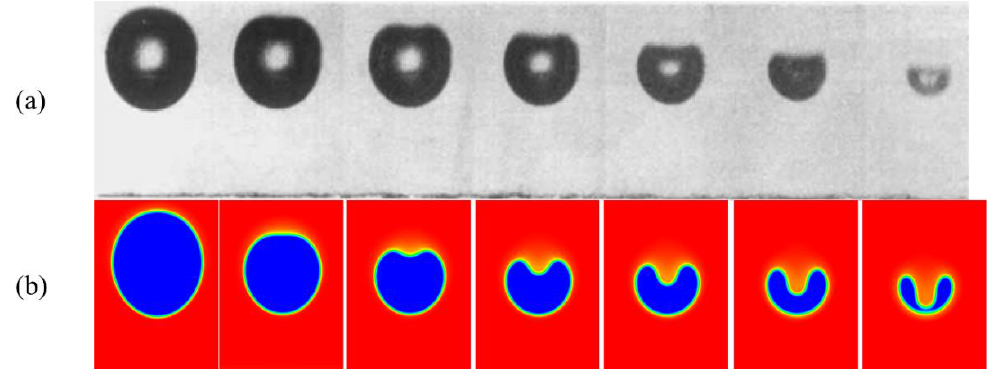
Figure 5. Comparison of experimental data and numerical results by DDF-LBM model. ( a ) Experimental data [60], reproduced or adapted from adequate reference, with permission from publisher Cambridge University Press, 2021. ( b ) Simulation results.